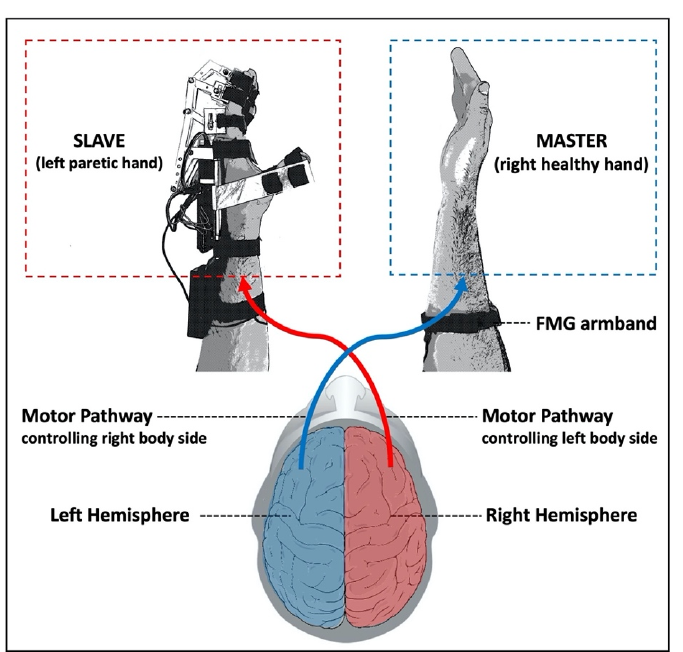
Figure 6. Example of symmetrical master–slave motion strategy: the user’s healthy hand on the master side (right hand) activates the motion for the paretic hand on the slave side (left hand).